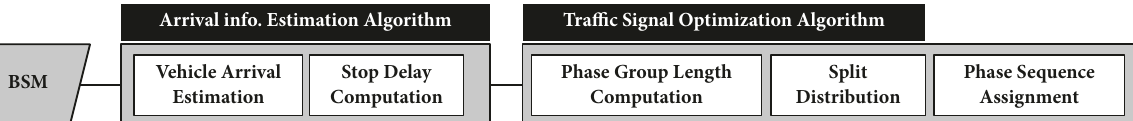
Figure 2: Configuration of the V2I-based signal control algorithm.